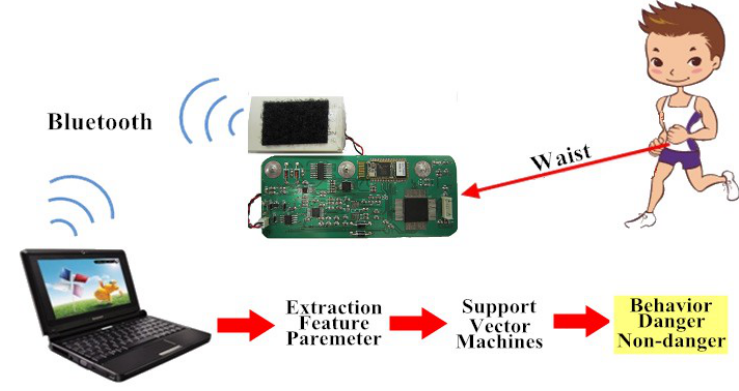
Figure 1. Overview of